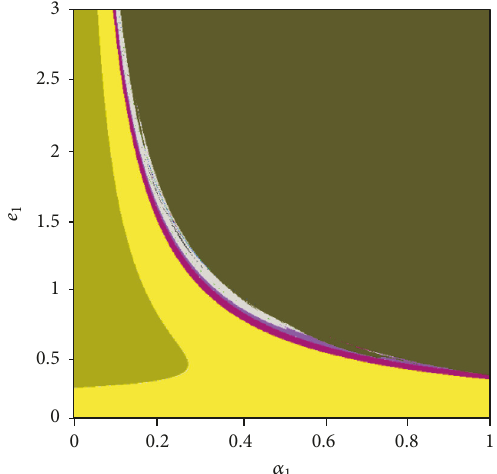
Figure 8: (𝑒 1 ,𝛼) -2D bifurcation diagram with 𝛽 = 0.1 and 𝛾 = 0.25 .